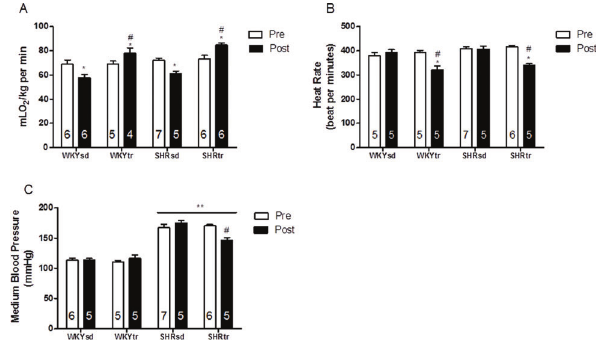
Figure 1 - Hemodynamics and effort test variables pre- and post- aerobic training or the sedentary period.Peak oxygen uptake (A); HR (B); and MBP (C). * p o 0.05; post-training compared with pre- training; # p o 0.05; trained group after training compared with the sedentary group after training; and ** p o 0.01, SHR vs . WKY. The data are presented as the mean ± SEM.